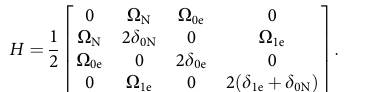
NATURE COMMUNICATIONS|7:12279|DOI: